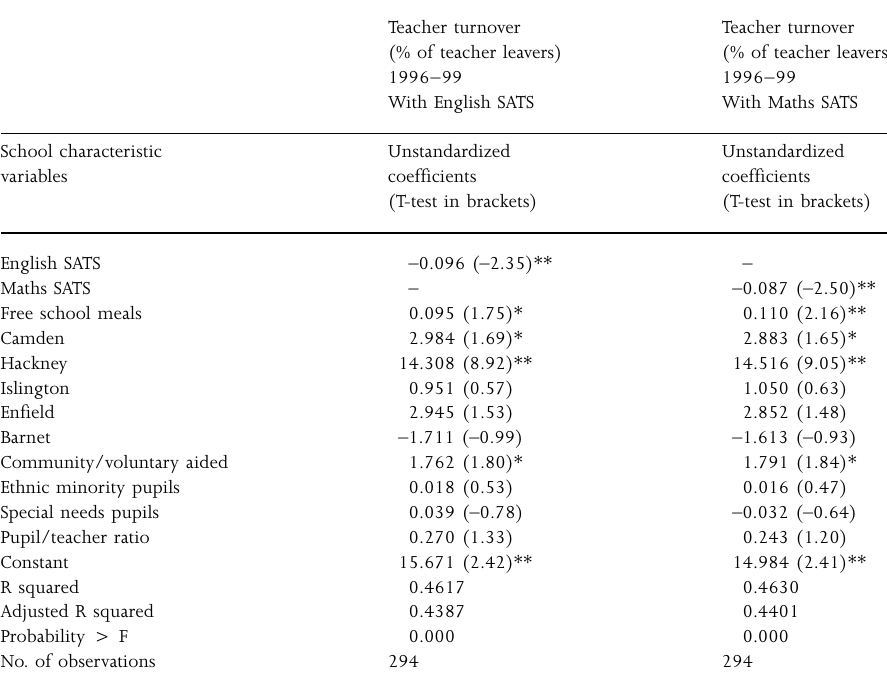
Table 2 The relationship between turnover and school